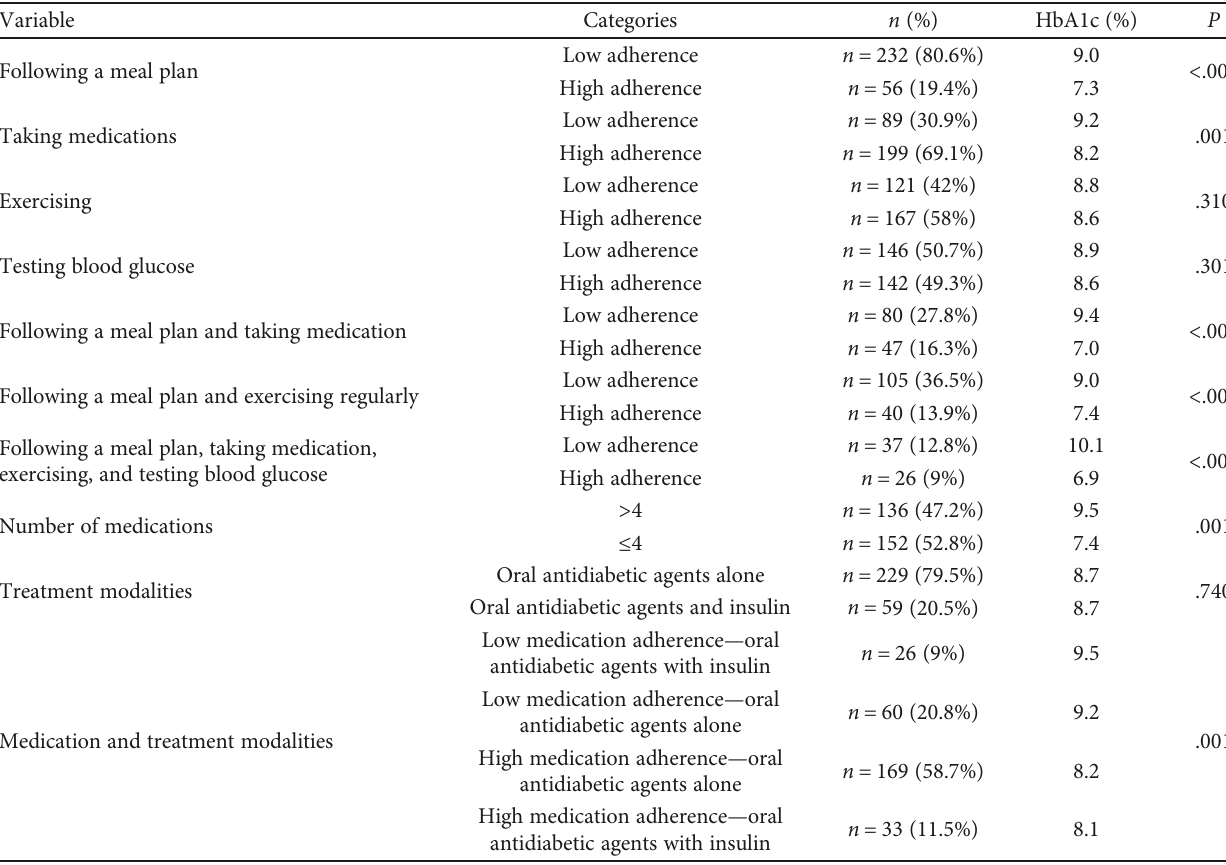
Table 2: Self-care behavior ’ s adherence and